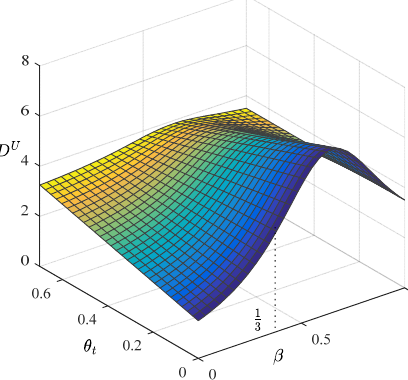
Figure 6. Demand of the retail system in Scenario D.